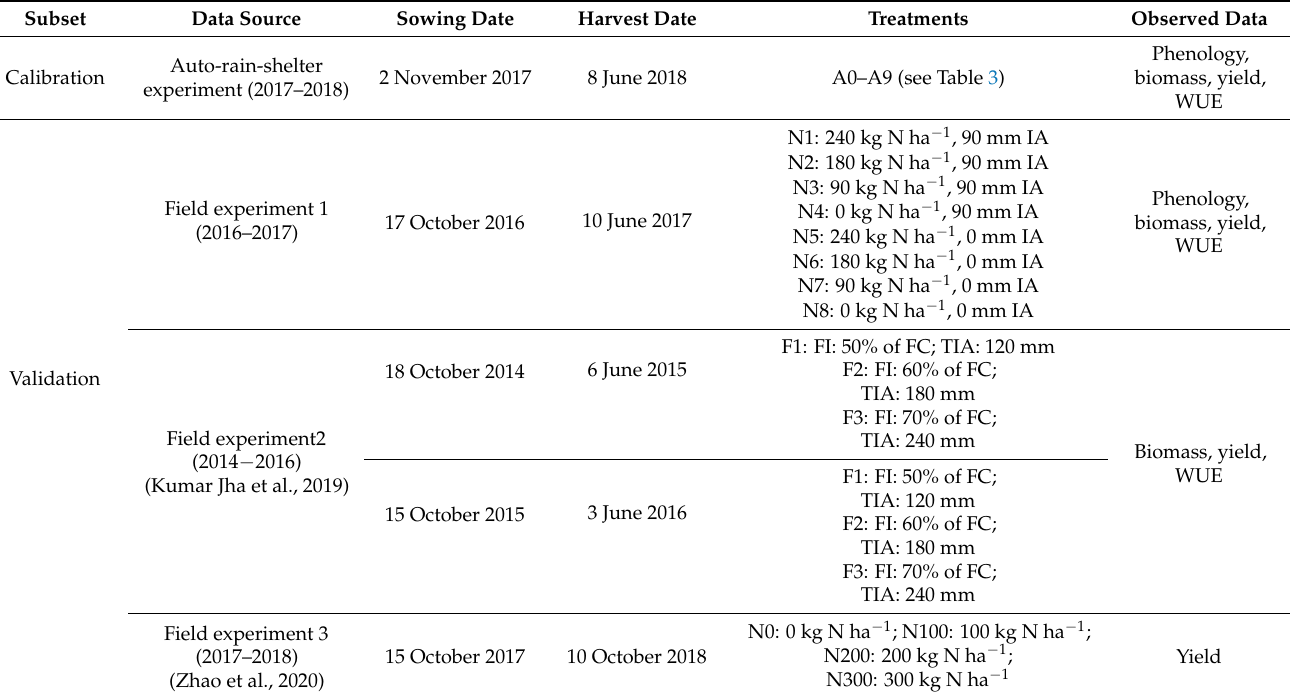
Table 4. Detailed experimental and literature information about wheat cultivar “Aikang58” for model calibration and